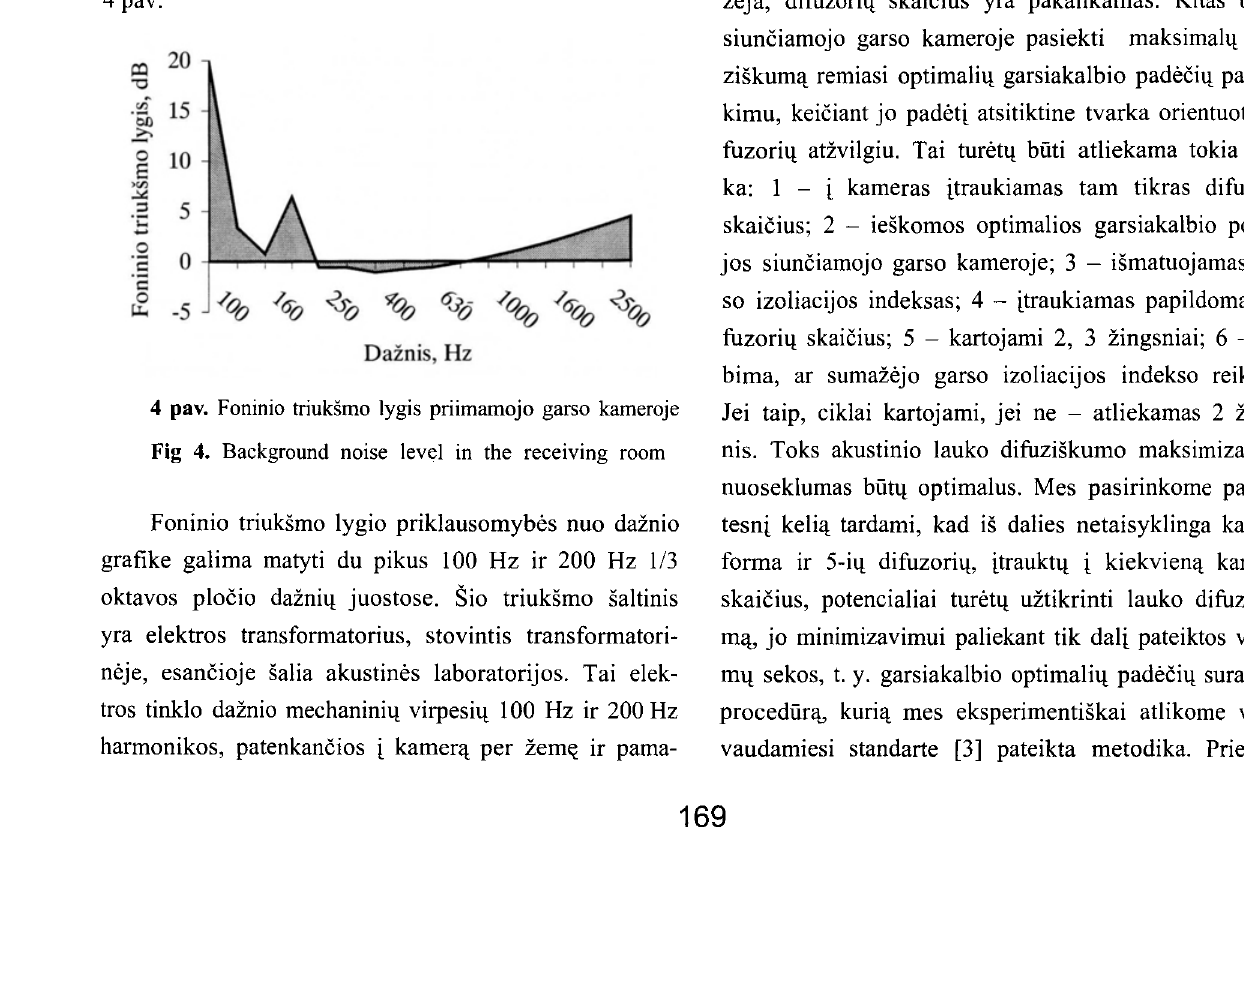
Fig 4. Background noise level in the receiving